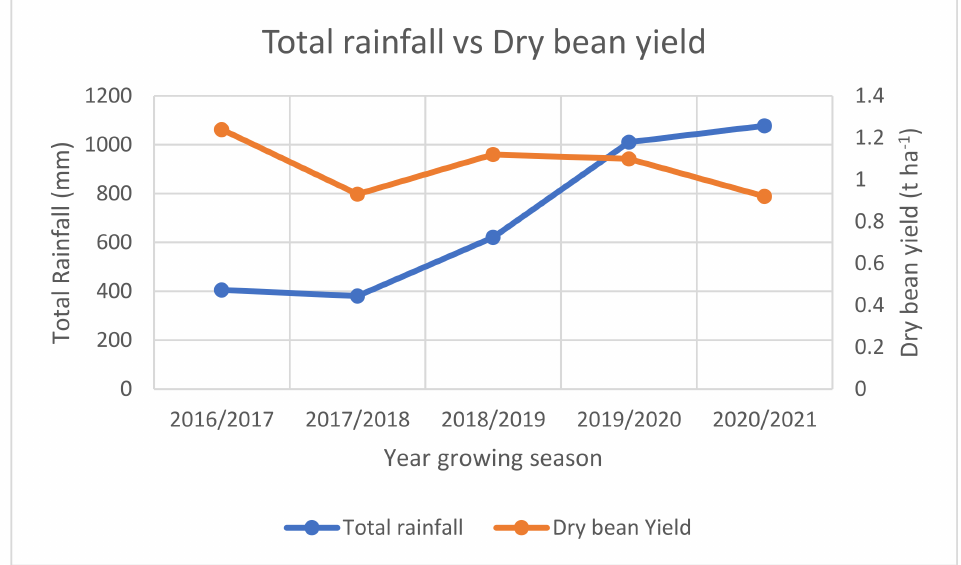
Figure 7. Relationships between total rainfall and dry bean yields during 2016/2017 to 2020/2021 growing seasons. Blue: total rainfall. Source: Weather and Climate [34]; Yellow: dry bean yield. Source: own data gathered from survey during the study.